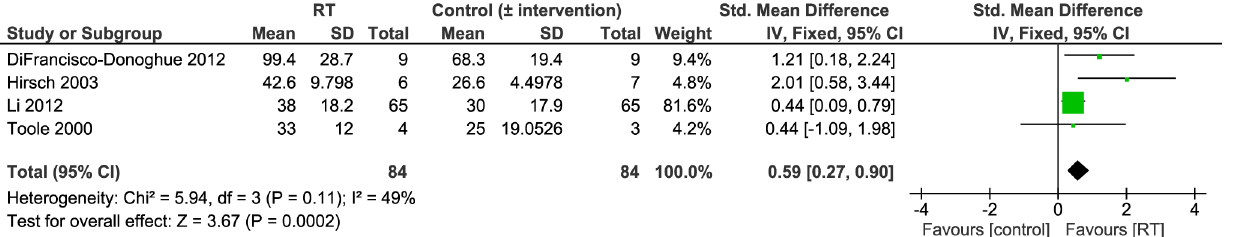
Fig 6. Primary analysis forest plot of comparison: RT vs. control-without/with-intervention, using post-intervention values, outcome: knee flexion strength. CI = confidence interval; IV = inverse variance; SMD = standardized mean difference.